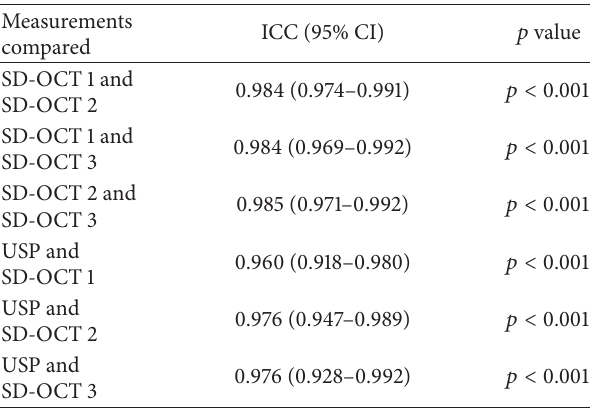
Table 3: Pairwise comparison of ICC values and confidence inter- vals.